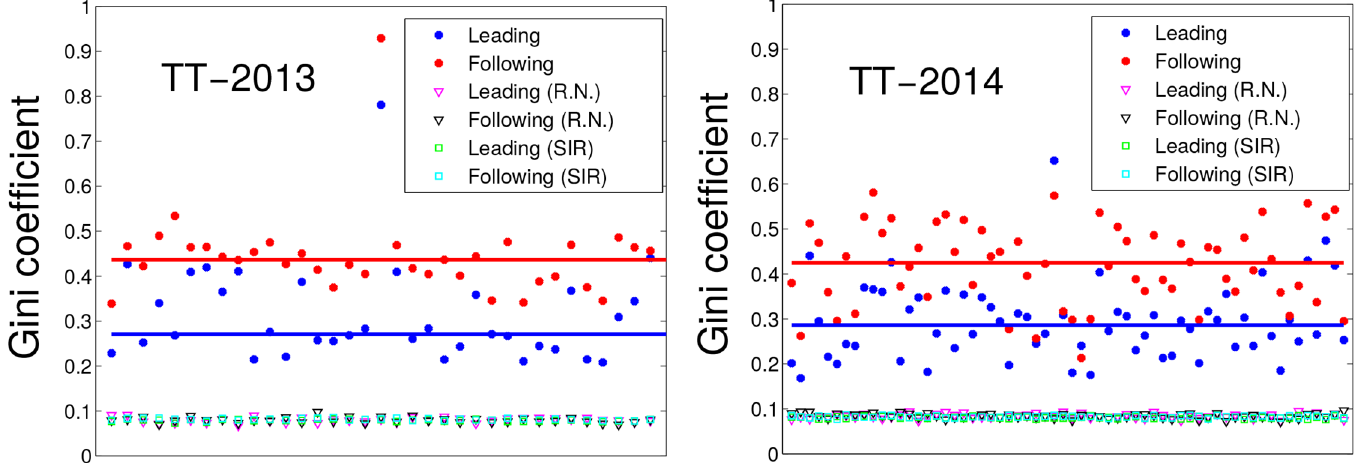
Fig 3. Leading and Following Gini coefficients. Each Gini coefficient is calculated for the networks of leading-following relations in each dataset and mean values for ten simulations of random networks and SIR processes. Horizontal lines show means over all countries.